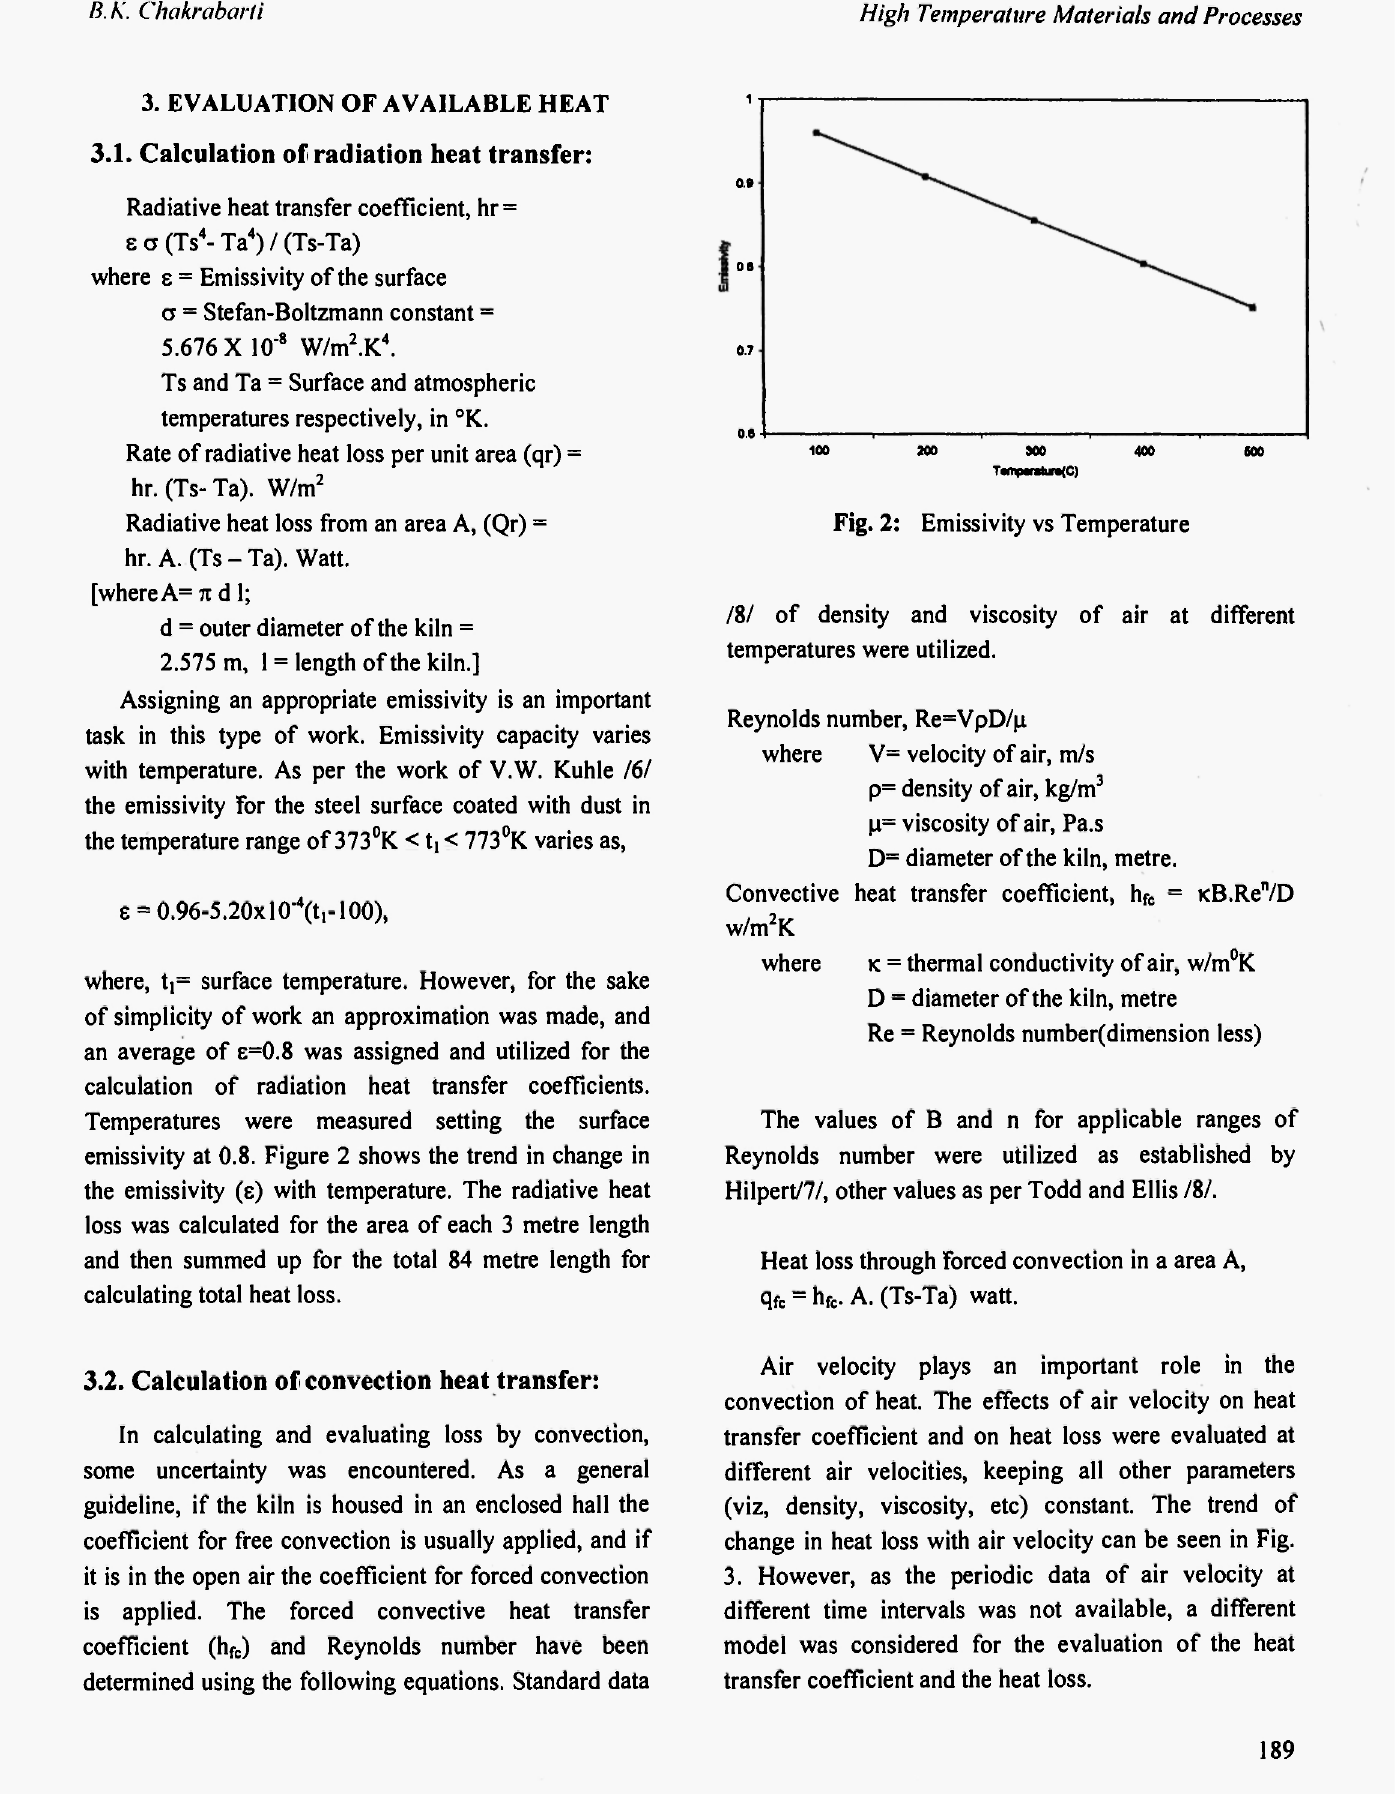
Fig. 2: Emissivity vs Temperature